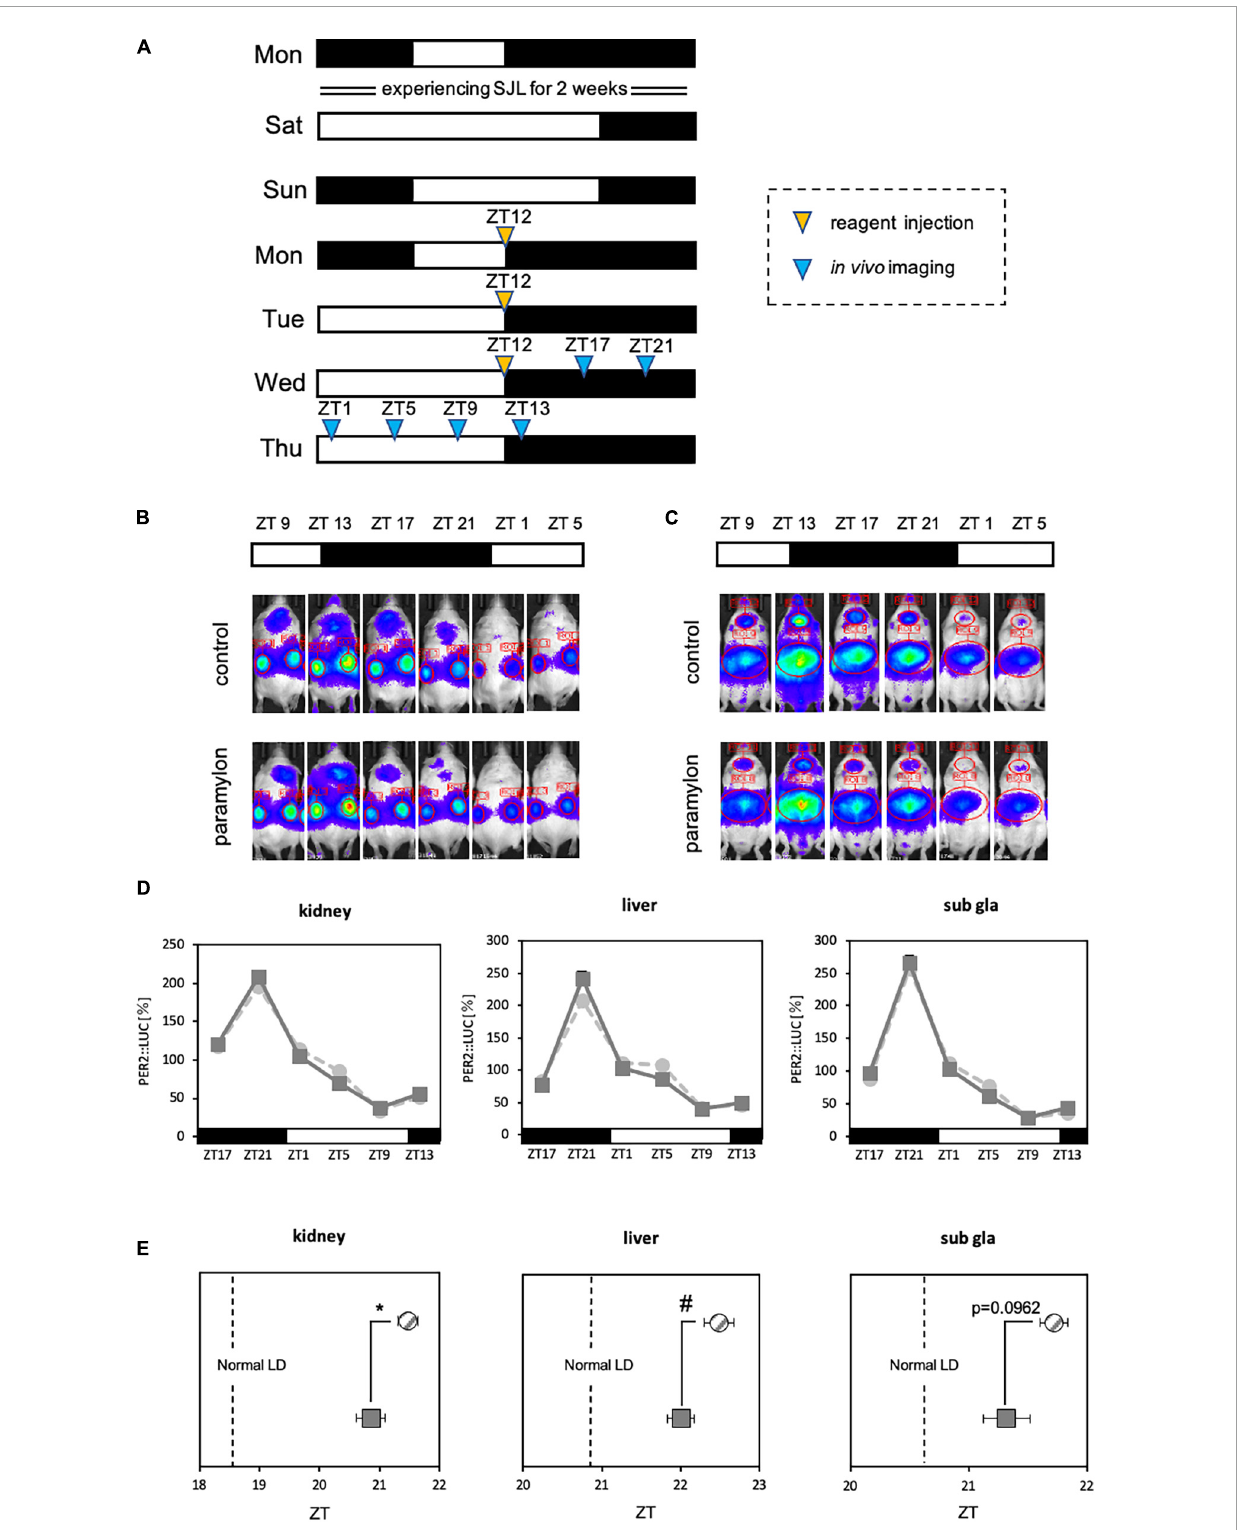
FIGURE6 Paramylon intake assists with the reentrainment of peripheral clocks under conditions involving social jetlag. (A) Experimental schedule. The yellow arrowhead indicates the reagent administration time, and the blue arrowheads indicate timings of in vivo bioluminescence imaging. (B,C) Representative images of in vivo bioluminescence imaging. (B) The luminescence observed in the kidney. (C) The luminescence observed in the liver and submandibular gland. (D) Waveform of PER2: LUC rhythm in each tissue. Light gray dotted lines indicate the control group, and dark gray lines indicate the paramylon group. (E) Peak phase of PER2: LUC rhythm in each tissue. Gray striped dots indicate the control group, and dark gray dots indicate the paramylon group. The vertical dotted lines indicate the phase under the normal LD condition (the control group of Figure 3 ) ( n = 10). * p < 0.05, vs. control group (Student’s t -test), # p < 0.05, vs. control group (Mann-Whitney